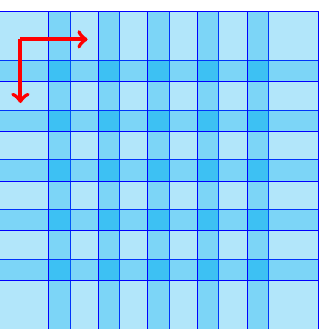
Figure 1. Overlapping patches in Rubinstein K-SVD algorithm and related horizontal ( a ) and vertical ( b ) shift.